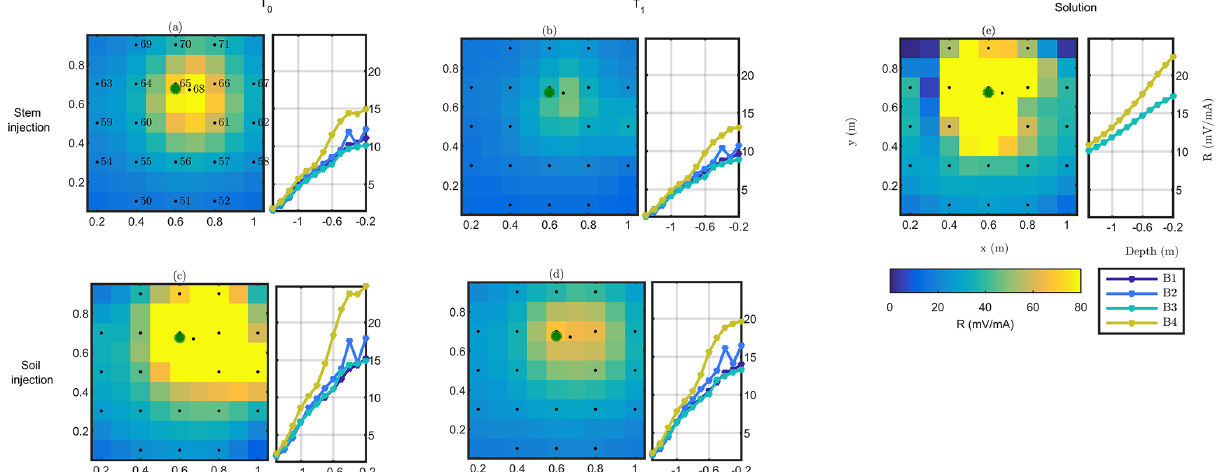
Figure 5. Plant B MALM results showing variations in surface (horizontal plan) of resistance R (in mVmA − 1 ) for the initial state back- ground T 0 (a, c) and irrigation T 1 (b, d) time steps. Comparison between the stem injection (a, b) and soil injection (c, d) . The black points show the surface electrode location. The green point shows the positions of the plant stem. Data are filtered using a threshold on reciprocal acquisition of 20%. Panel (e) shows the solution using Eq. (4) for a homogeneous soil of 100 (cid:127) m; the resistances between boreholes B1/B3 and B2/B4 (see legend) are identical and cannot be distinguished graphically in the case of (e)